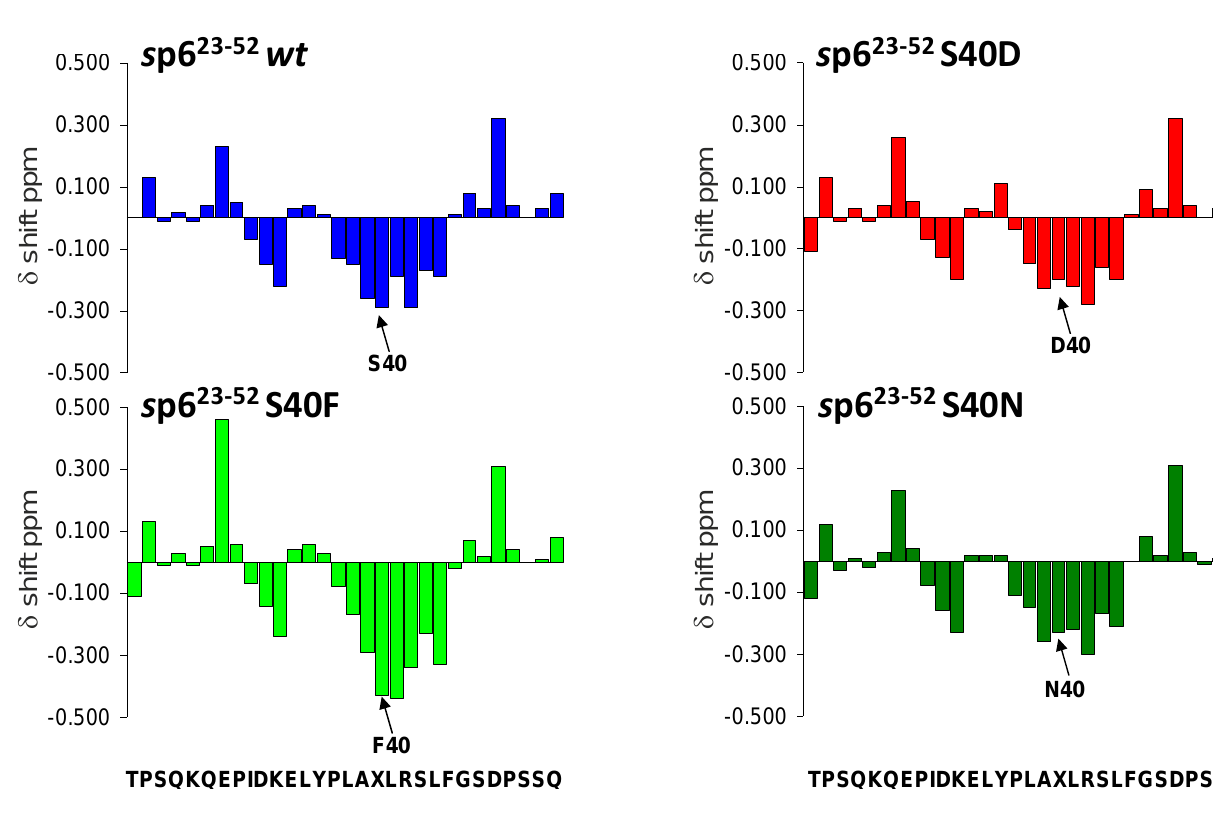
Figure 8. Mutations of Ser-40 do not change the extent or position of the secondary structure of the C-terminus of p6. Chemical shift differences (ppm) of the α-protons between the experimental values and those for residues in a random coil for the C-terminal peptides s p6(23-52) wt and the mutants s p6(23-52)S40F, s p6(23-52)S40D and s p6(23- 52)S40N in 50% aqueous TFE at pH